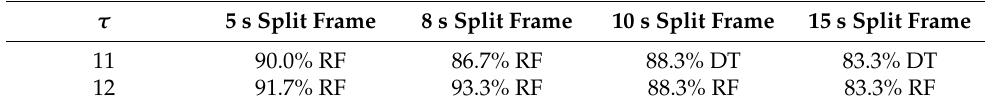
Figure 6. Probability density curve of the embedding dimension. Table 4. VF prediction accuracy of superior classifiers.